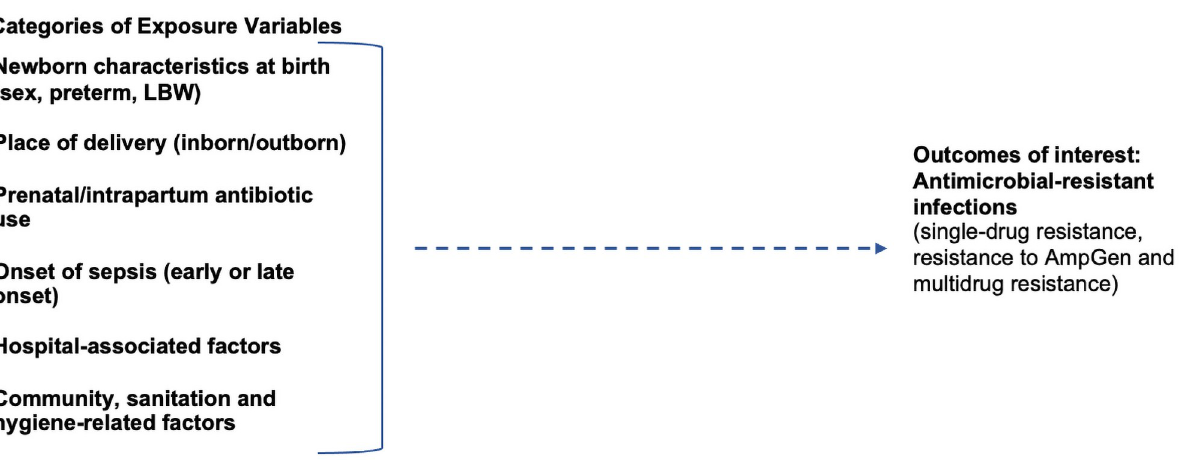
Fig 2. Conceptual framework. The conceptual framework describes the associations assessed in this study between exposures variables and the outcome of interest: antimicrobial-resistant infections.